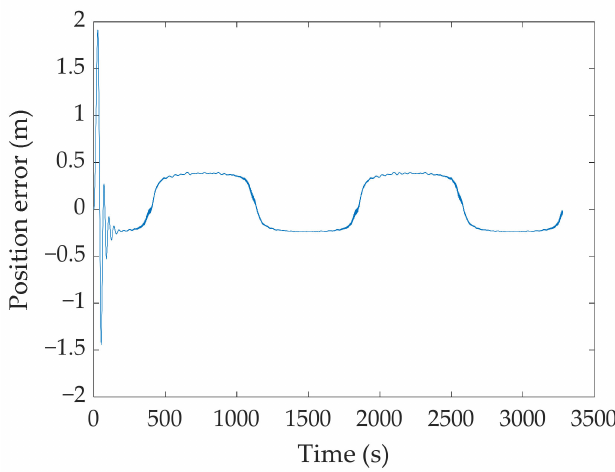
Figure 11. Position error for the sine path